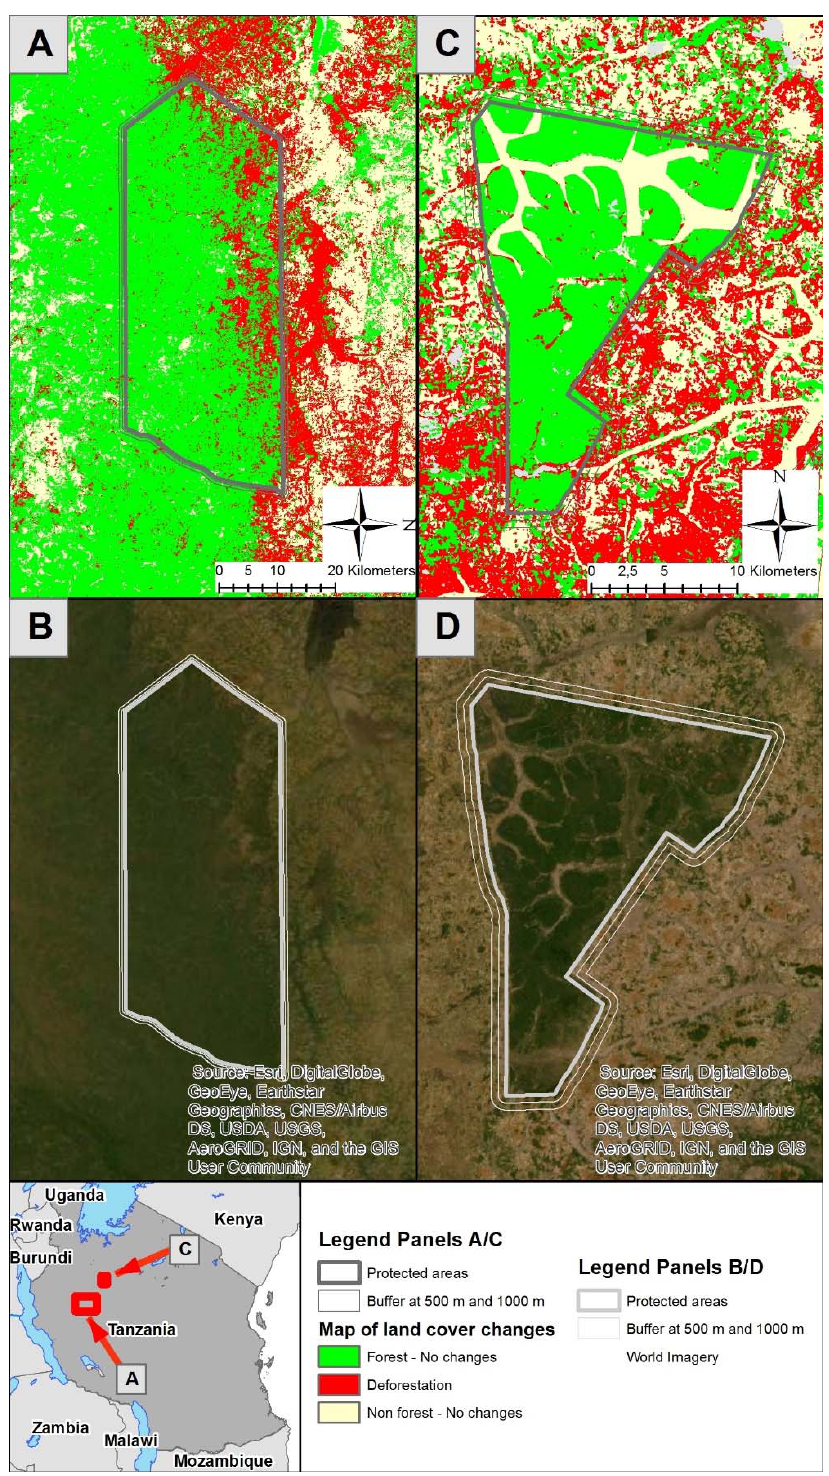
Figure 4. Example of PAs with negligible deforestation inside their boundaries (Panels ( C , D ), Karitu Forest Reserve) and with a sizeable and advancing deforestation inside the boundary (Panels ( A , B ); Ugala North Forest Reserves), in western Tanzania.